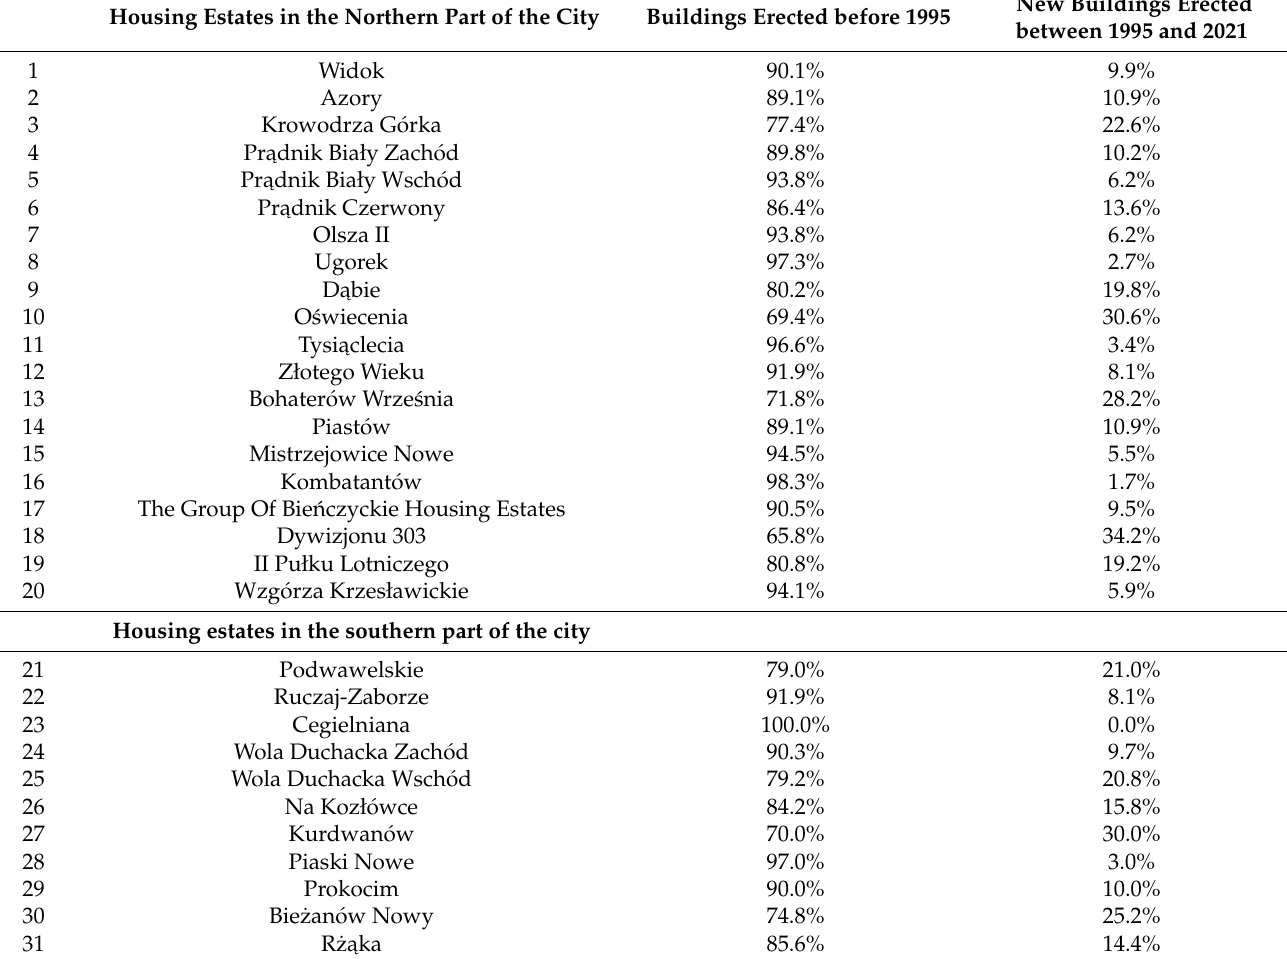
Table 1. Densification values for large-panel housing estates in Cracow